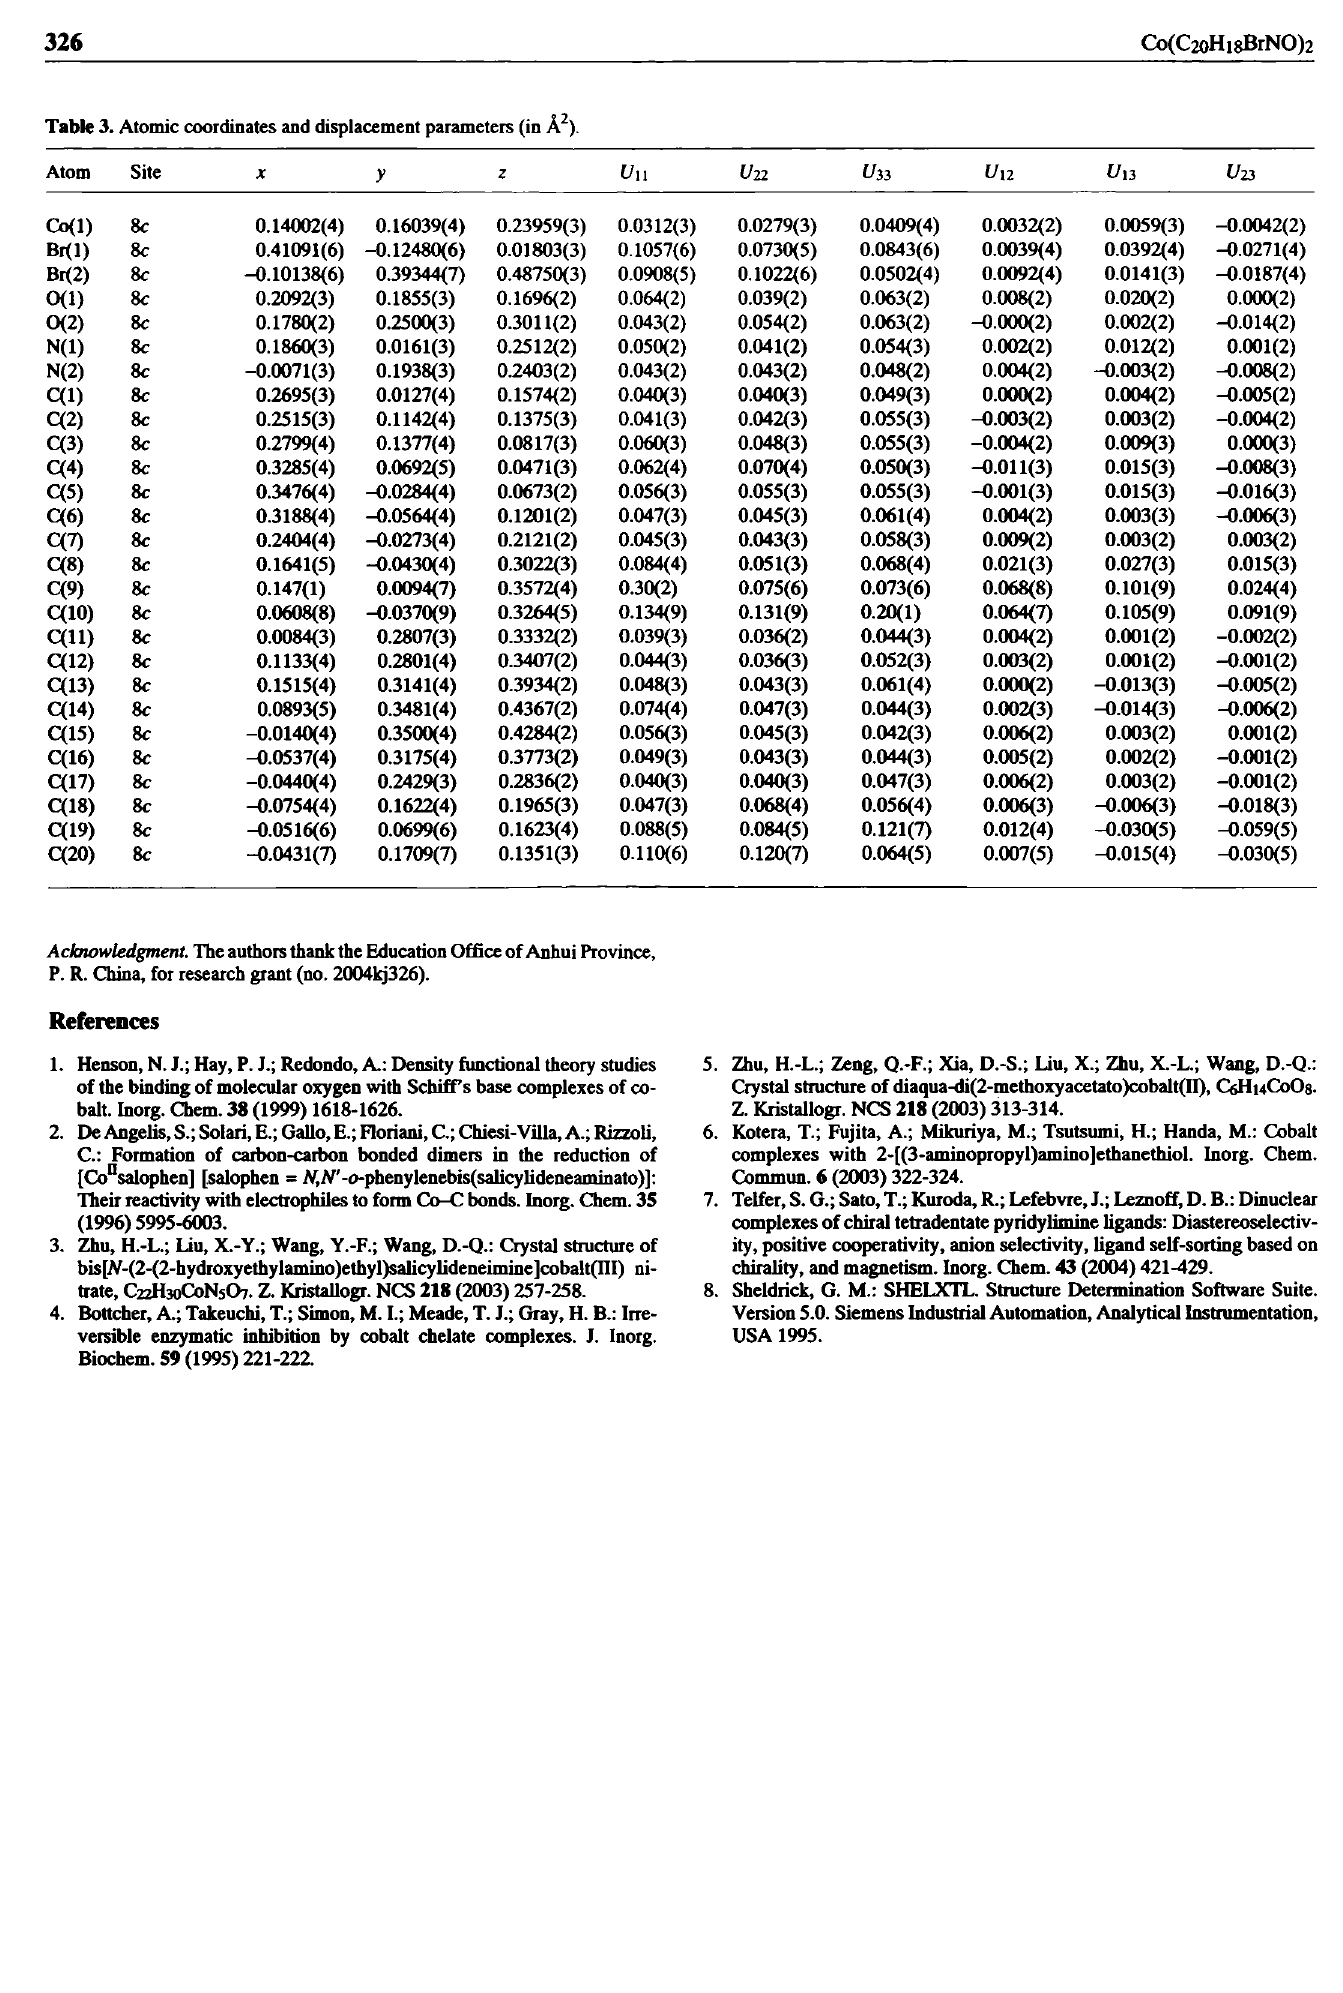
Table 3. Atomic coordinates and displacement parameters (in Ä 2